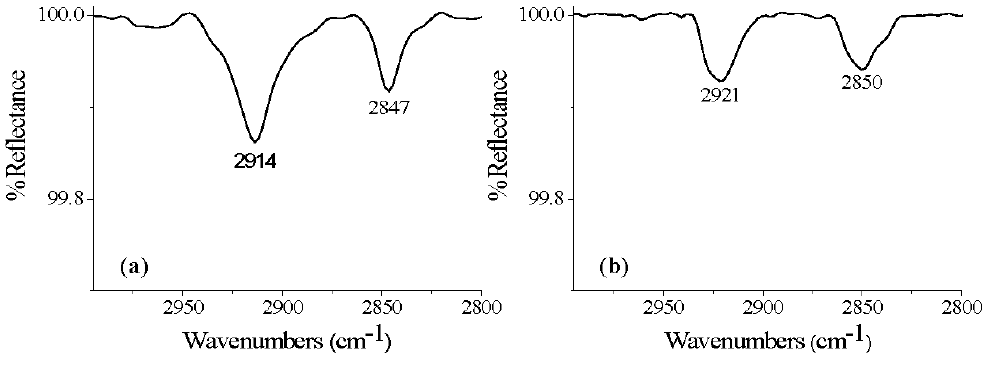
Figure 1. DRIFT spectra of methylene region of ( a ) hexacosanoic acid (HCA); and ( b ) eicosanoic acid (ECA) on Ti-6Al-4V, following sonication.